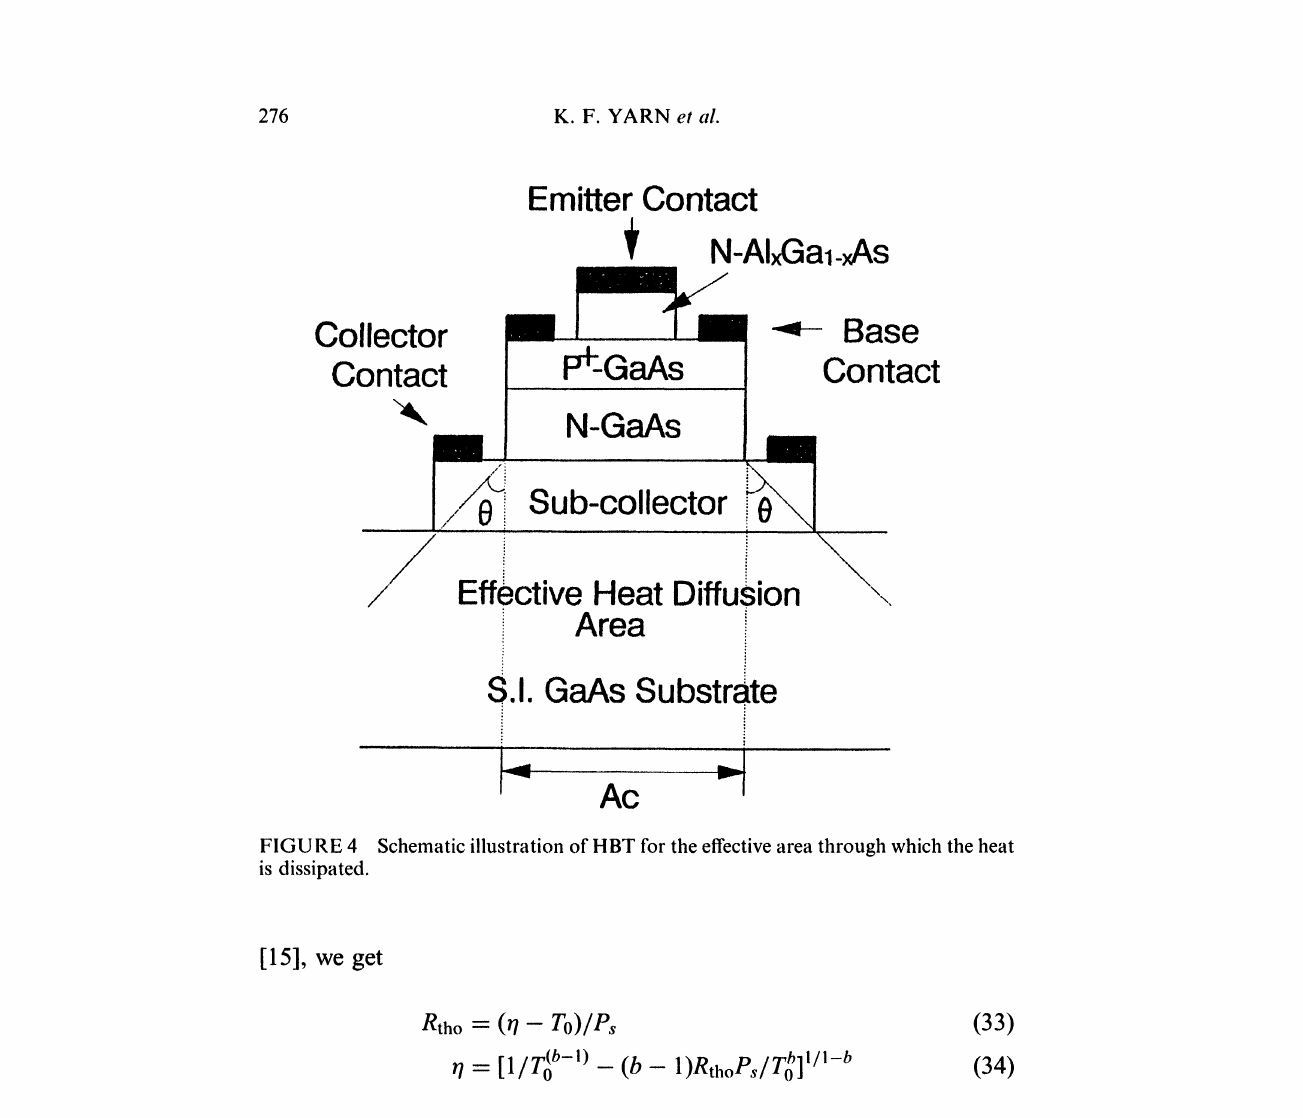
FIGURE 4 Schematic illustration of HBT for the effective area through which the heat is